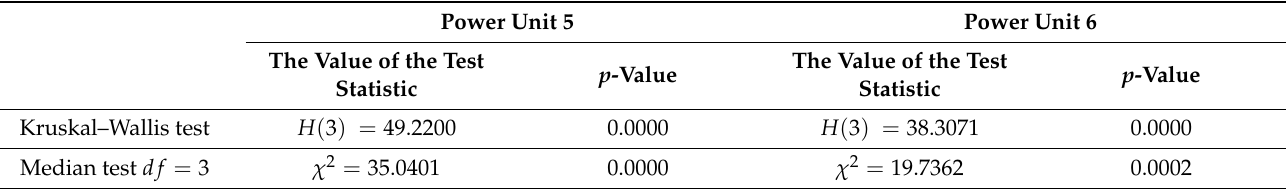
Table 2. Test results for the variable water temperature difference– ∆ T w [ ◦